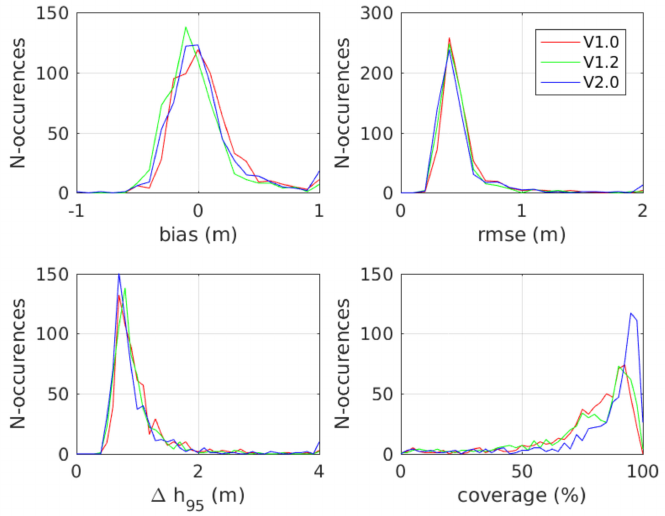
Figure 14. Histograms of the four basic performance statistics for each of the three algorithm versions (colors).